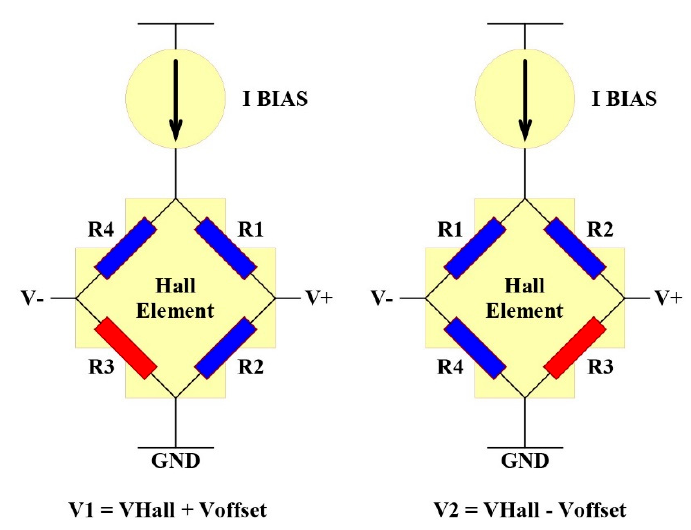
Figure 1. Wheatstone bridge model of a Hall sensor biased with a constant current source and exhibiting an offset voltage.